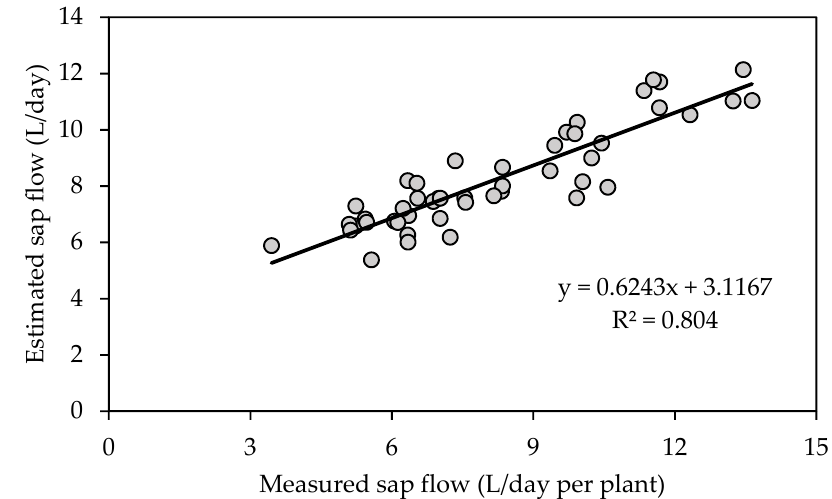
Figure 11. Measured vs. estimated sap flow during the validation process.